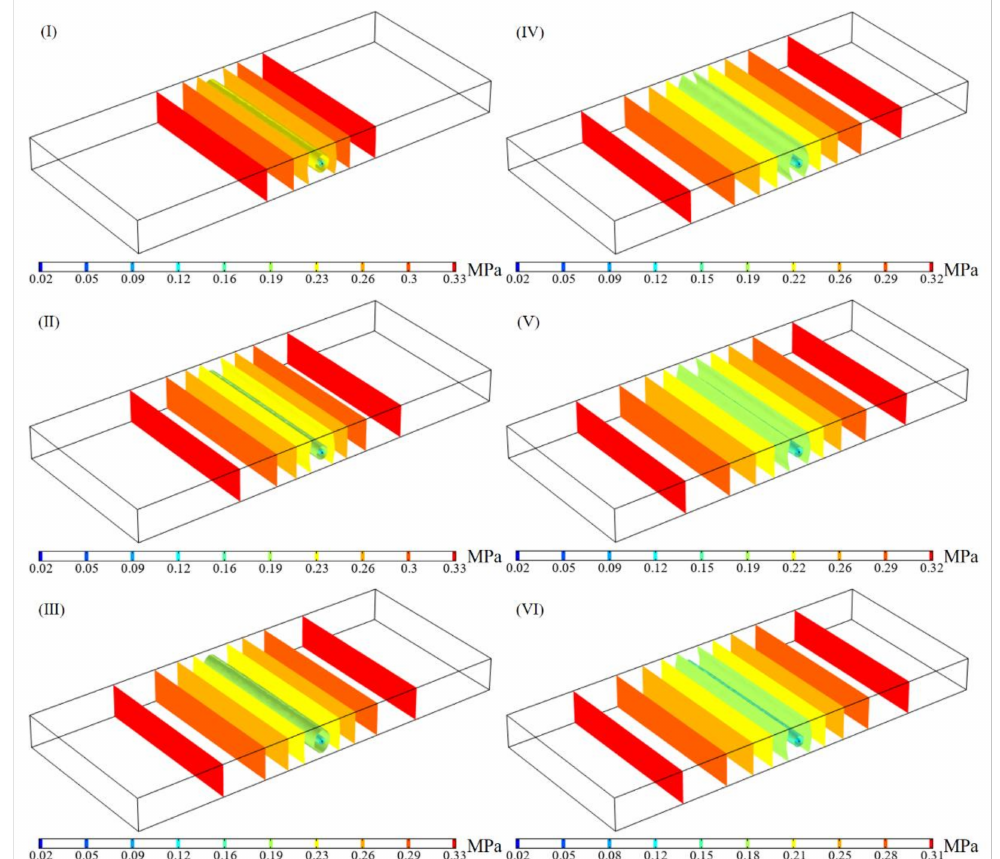
Figure 13. Three-dimensional cloud chart of gas pressure distribution around boreholes at different